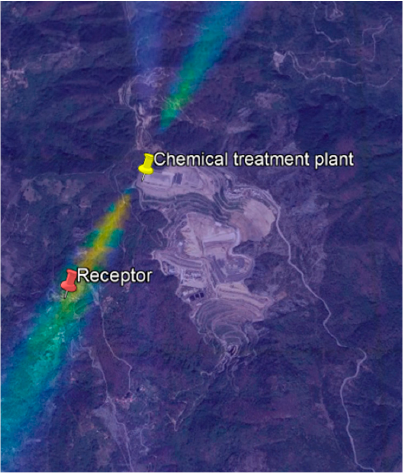
Figure 4. Receptor chosen for the ingestion exposure assessment.